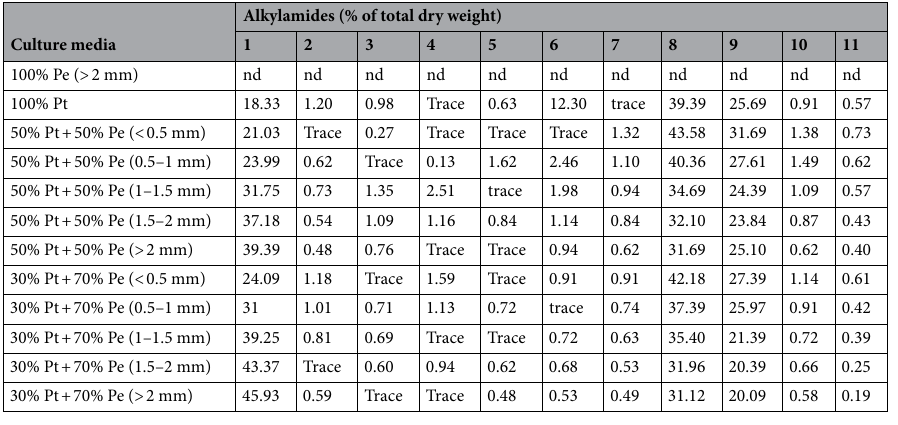
Table 4. Alkylamides percentage of E. purpurea grown at different culture media and 70:30 NO 3− /NH 4+ ratio. nd not detected (very low